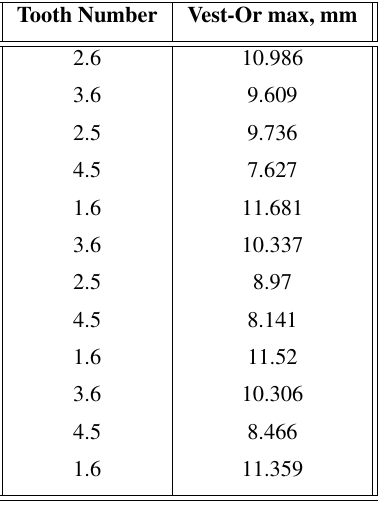
Table 1. Maximal vestibular-oral dimensions of teeth